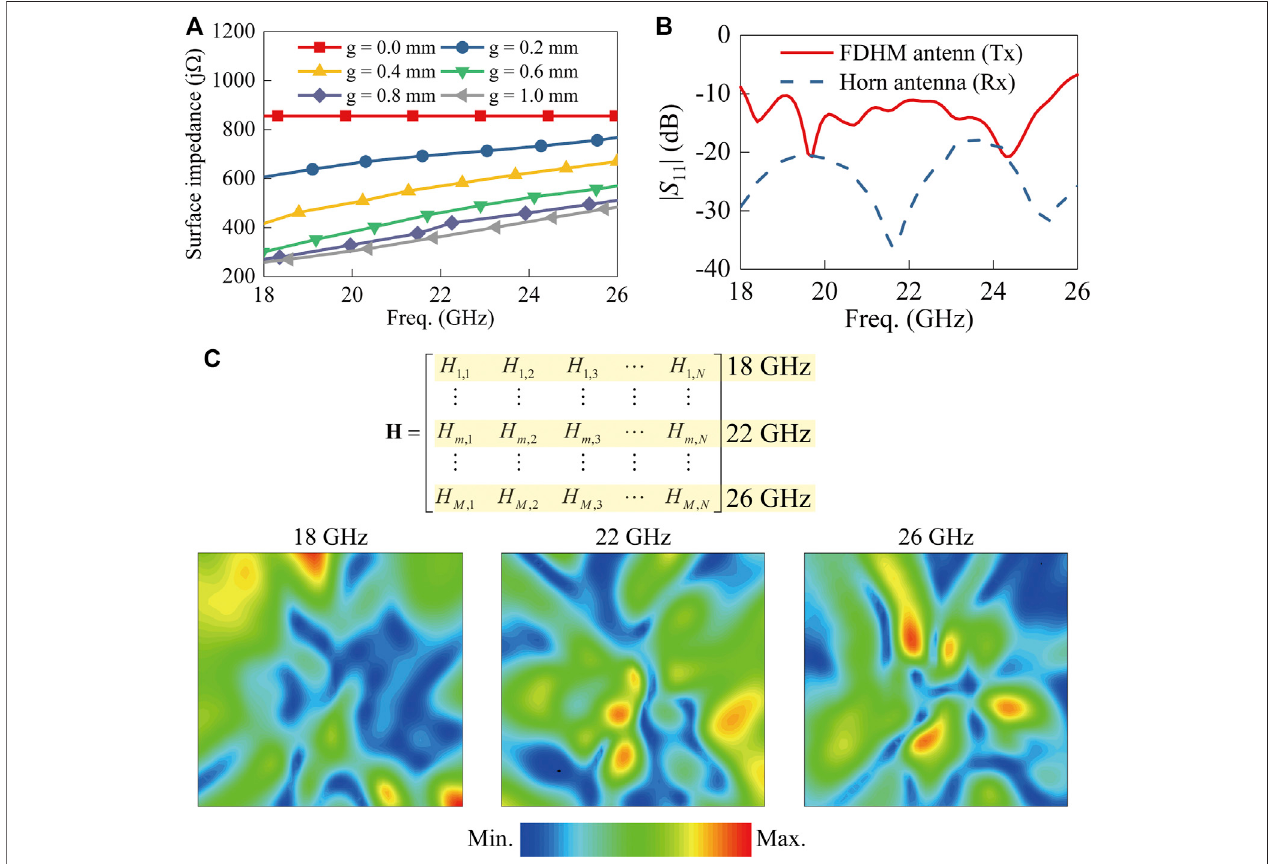
FIGURE 3 | (A) Surface impedance versus frequency for various gaps. (B) Simulated return losses for the FDHM antenna and horn antenna. (C) Randomly distributed sensing patterns at different frequencies.